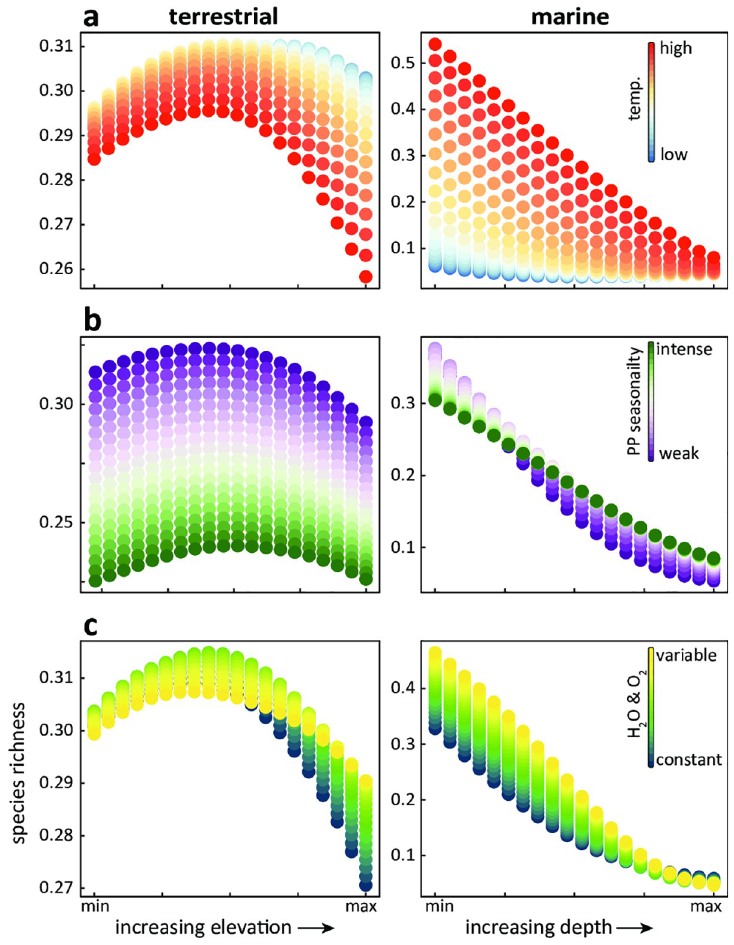
Fig 3. Multivariate partial dependence plots offer a chance to better grasp driver interactions. These plots show the neural networks’ approximation of driver richness relationships when two inputs co-vary. In this example, we see how species richness is expected to respond across different temperatures (a), seasonality in primary productivity (b) and limiting biogeochemical variables (c) in response to changing depth and elevation. This is an example of the power of ANNs to approximate functions and the integration of interactions. This can be explored for any possible